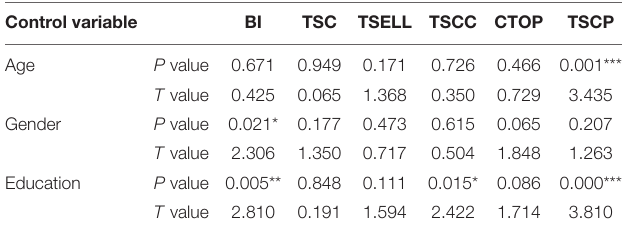
TABLE 8 | Explained variance and predictive relevance. TABLE 9 | Impact of control